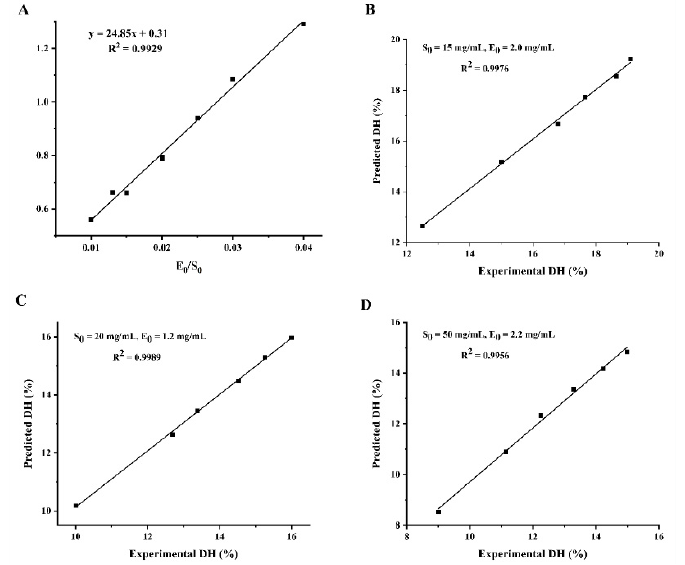
Figure 3. Validation of the WIP hydrolysis kinetic model. ( A ) Linear relationship between parameter a and E 0 /S 0 ; ( B – D ): correlation between predicted and actual values of hydrolysis under different enzyme and substrate concentrations. ( B ) S 0 = 15 mg/mL, E 0 = 2.0 mg/mL; ( C ) S 0 = 20 mg/mL, E 0 = 1.2 mg/mL; ( D ) S 0 = 50 mg/mL, E 0 = 2.2 mg/mL.